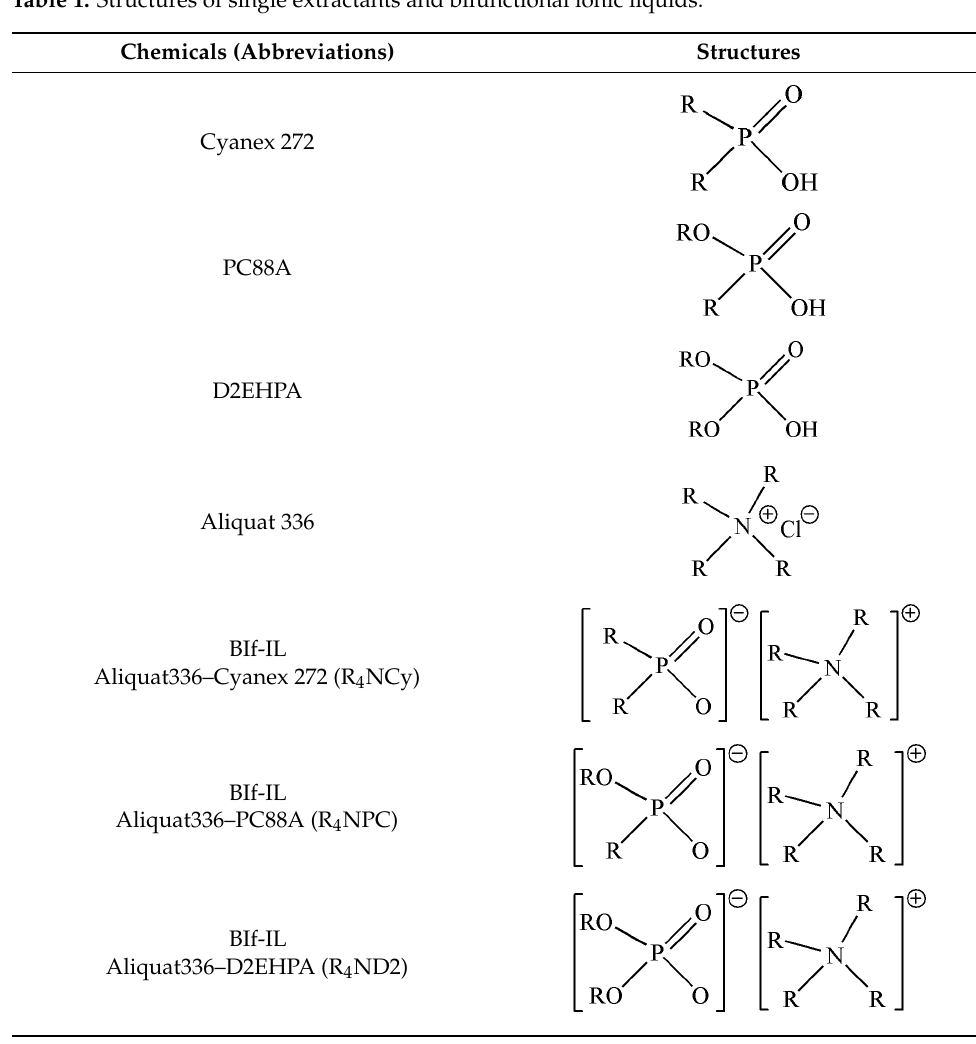
Table 1. Structures of single extractants and bifunctional ionic liquids.